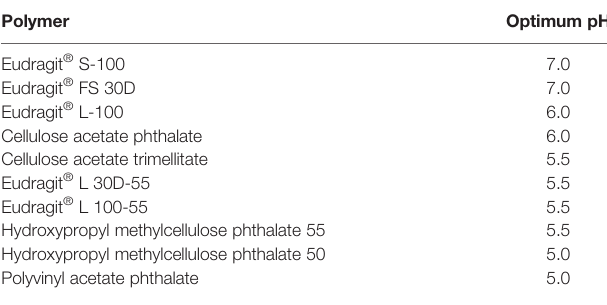
TABLE 2 | Examples of pH-dependent polymer coatings used for colonic targeting.